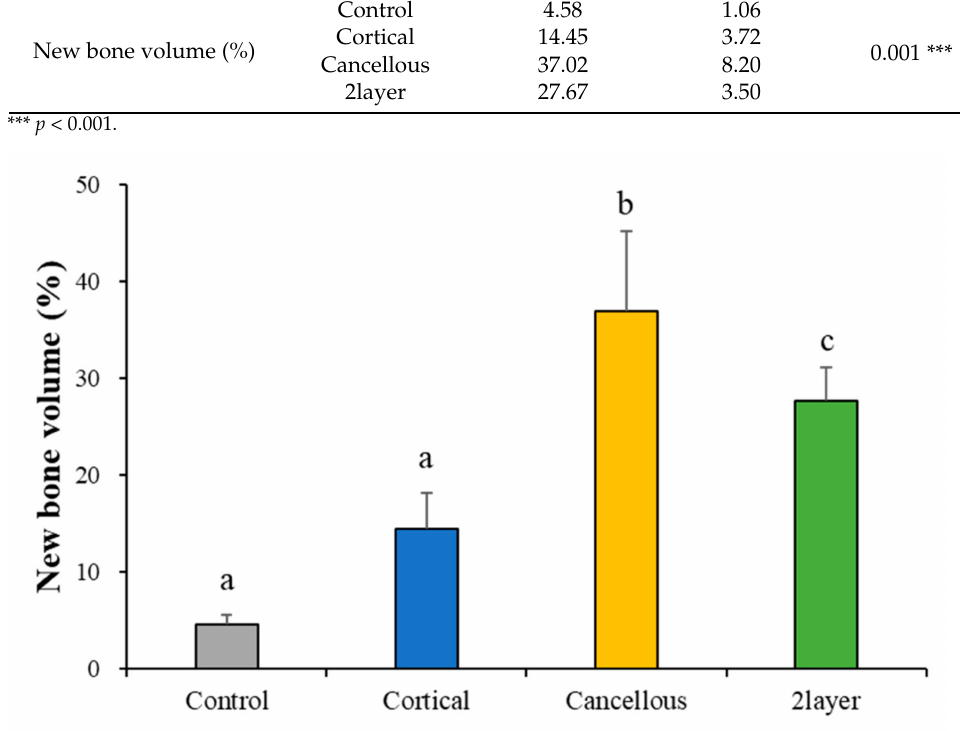
Figure 8. Volumetric measurement of newly formed bones. Different letters denote significant differences among each group ( p <